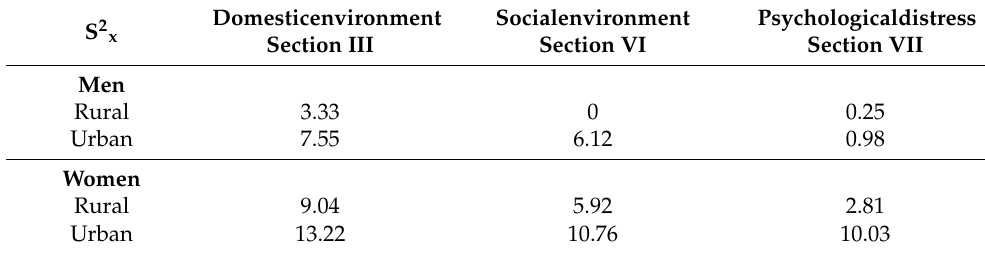
Table 6. Variance in PAIS-SR Sections III, VI and VII by place of residence and sex. Source: own